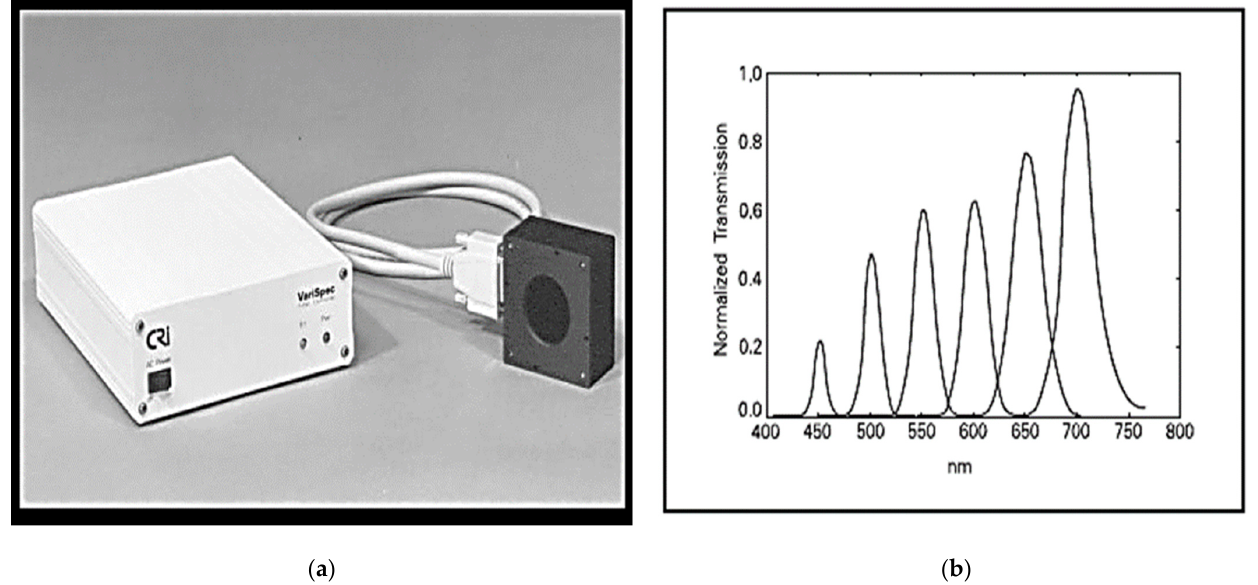
Figure 2. ( a ) The LCTF ( b ) The LCTF at several wavelength settings [19].